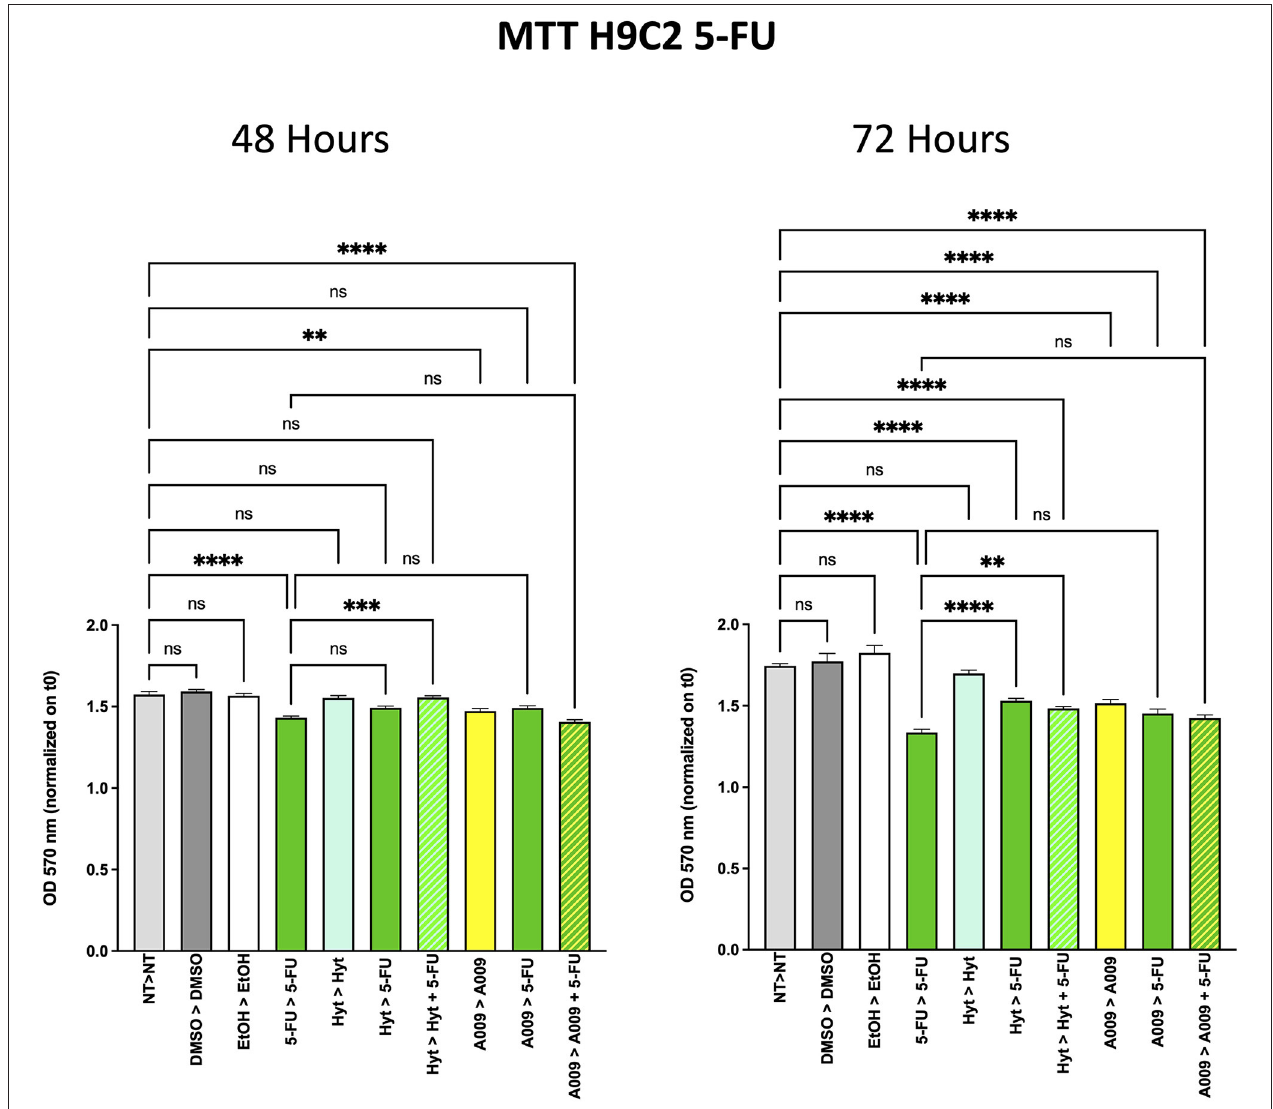
FIGURE 5 | Effects of the A009 extract in combination with 5-FU on rat cardiomyocytes. H9C2 cells were pretreated with extract A009 (dilution 1:800) or Hyt (same concentration as that present in the 1:800 diluted A009 extract), for 24h. Later, the medium was replaced with 5-FU 100 µ M alone or in combination with A009 or Hyt for 48 and 72h. Proliferation was detected by the MMT assay at the indicated time points. The experiments were performed in quadruplicate and repeated two times. Results are expressed as the mean of the absorbance normalized on the T0 SEM, one-way ANOVA, ** p < 0.01, *** p < 0.001, and **** p < 0.0001. A009 ± combinations with chemotherapy were less toxic toward cardiomyocytes than toward breast cancer cells. numbers of embryos displaying congenital abnormalities, when compared with embryos treated with doxorubicin alone ( Supplementary Tables 3, 4